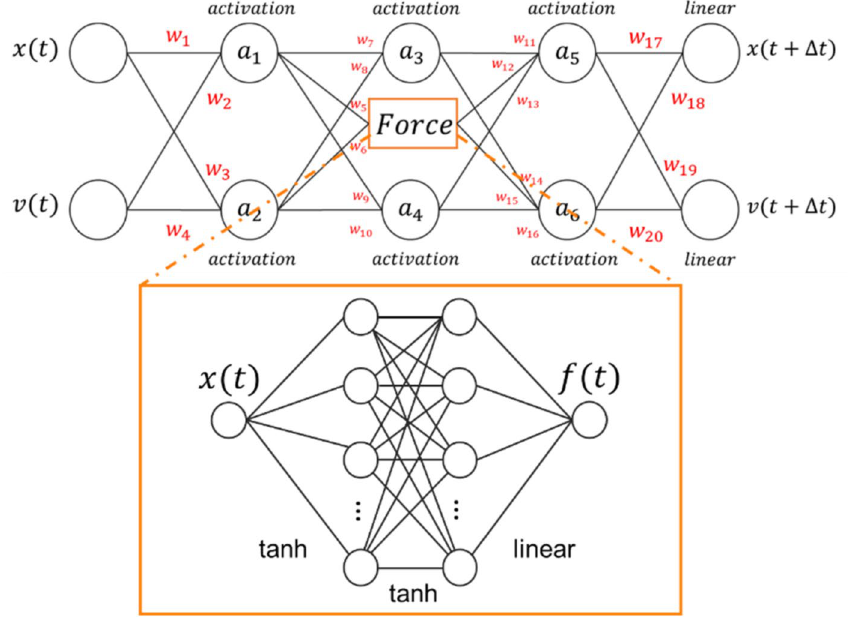
Figure 1. Neural network used as the starting point to find the parsimonious neural network as the network that explains the data in the simplest manner possible. The force sub-network is highlighted in orange and is fed into the neural network as a pre-trained model, whose weights are subsequently kept fixed